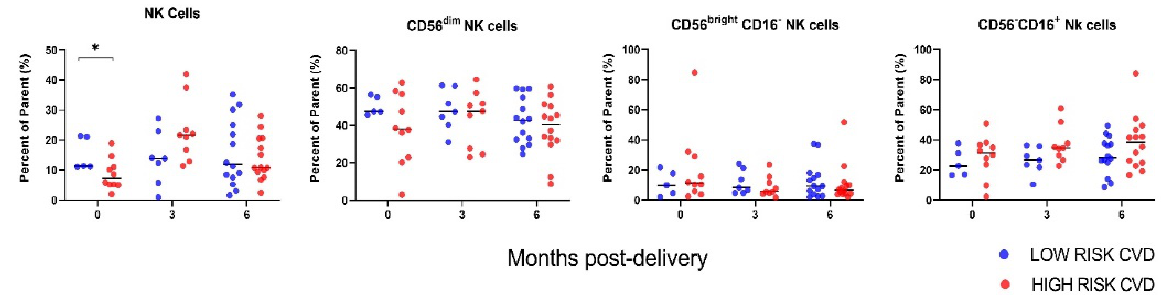
Figure 2. Maternal NK-cell profiles by CVD risk. Immune cell data are stratified by participant life- time CVD risk status at 6-months postpartum (low versus high). Results are reported as percent of the parent cell population (live/size/CD3 − CD45 + cells for all). Sample sizes at each time point: n = 15 at delivery, n = 16 at 3-months postpartum and n = 28 at 6-months postpartum. * p < 0.05 . Circulating B cells did not correlate with CVD risk at 6-months postpartum, and there were no variations in the number of monocytes (CD14 + CD11b + ) or inflammation-associ- ated loss of HLA-DR in the monocyte sub-population.